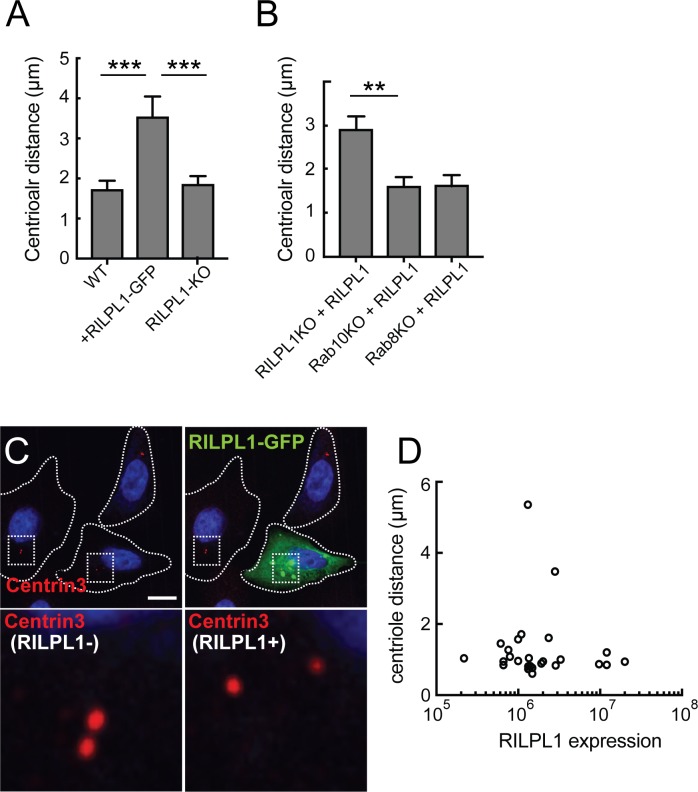
Exogenous RILPL1 expression disrupts centriolar cohesion.(A) Measurements of the distances (in µm) between centriole dots in WT A549 cells alone, A549 after RILPL1-GFP transfection and RILPL1-KO cells. (B) Measurements of the distance (in µm) between centrioles when RILPL1-GFP is expressed in A549 cells lacking RILPL1, Rab10 or Rab8A. (C) A549 cells transfected for 24 hr with RILPL1-GFP plasmid, stained with mouse anti-Centrin-3 (red) and DAPI (blue). Dotted lines indicate the cell boundaries; boxes indicate the regions of the images magnified in the lower panels. Scale bars, 10 µm. (D) Distance between centrioles as a function of RILPL1-GFP expression, determined by quantitation of GFP fluorescence in expressing cells. Error bars represent SEM from two experiments. *, p<0.05. **, p<0.01; ***, p<0.001 by Student’s unpaired, two tailed T-test.